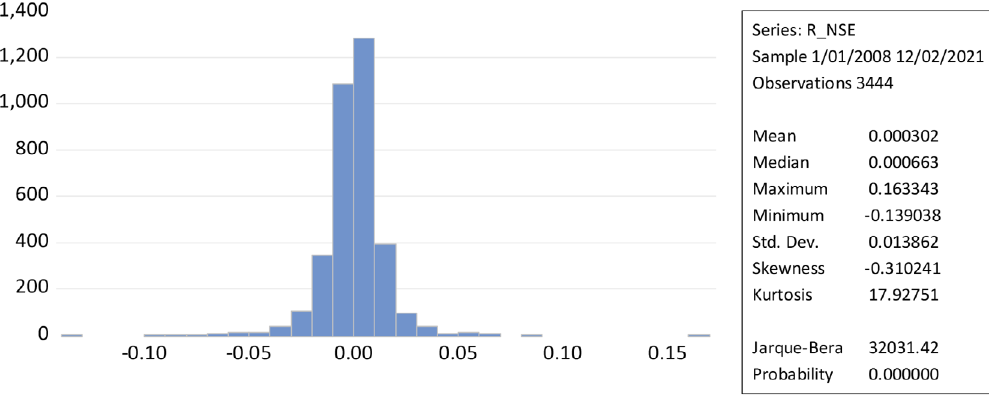
Figure 2. Time series and histogram plot of returns to NSE (source: author ’ s calculations). NSE: National Stock Exchange; RNSE: returns of NSE.